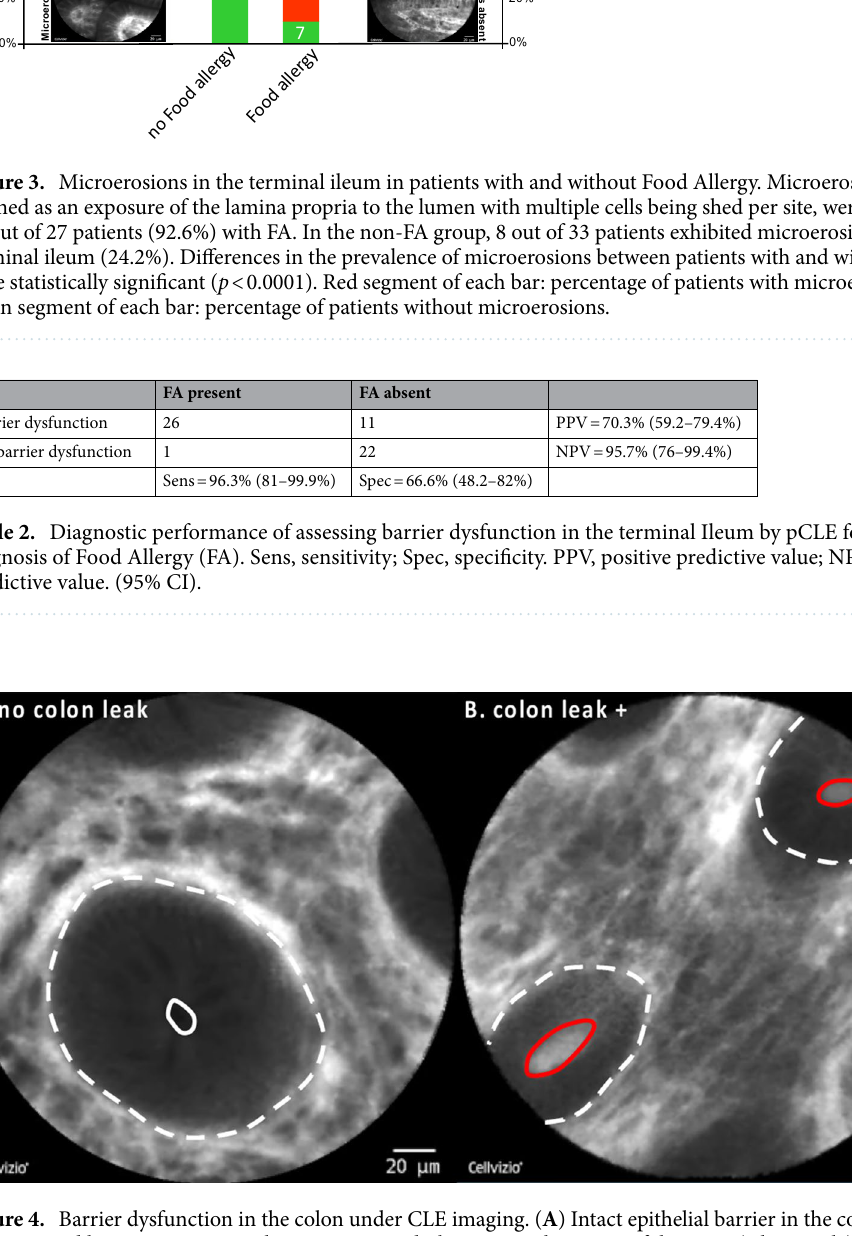
Figure 4. Barrier dysfunction in the colon under CLE imaging. ( A ) Intact epithelial barrier in the colon is characterized by a crypt opening that appears as a dark center in the center of the crypt (white circle). ( B ) During colonic barrier dysfunction, fluorescein leaks into the crypt lumen; therefore, the lumen is brighter than the surrounding epithelium (red circle). Dashed white line: colonic